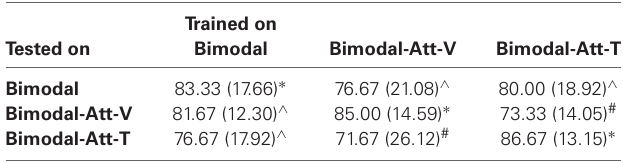
Table 2 | Classification accuracies (averages and standard deviations) for each class of cross-conditional classification. Trained on Tested on Bimodal Bimodal-Att-V